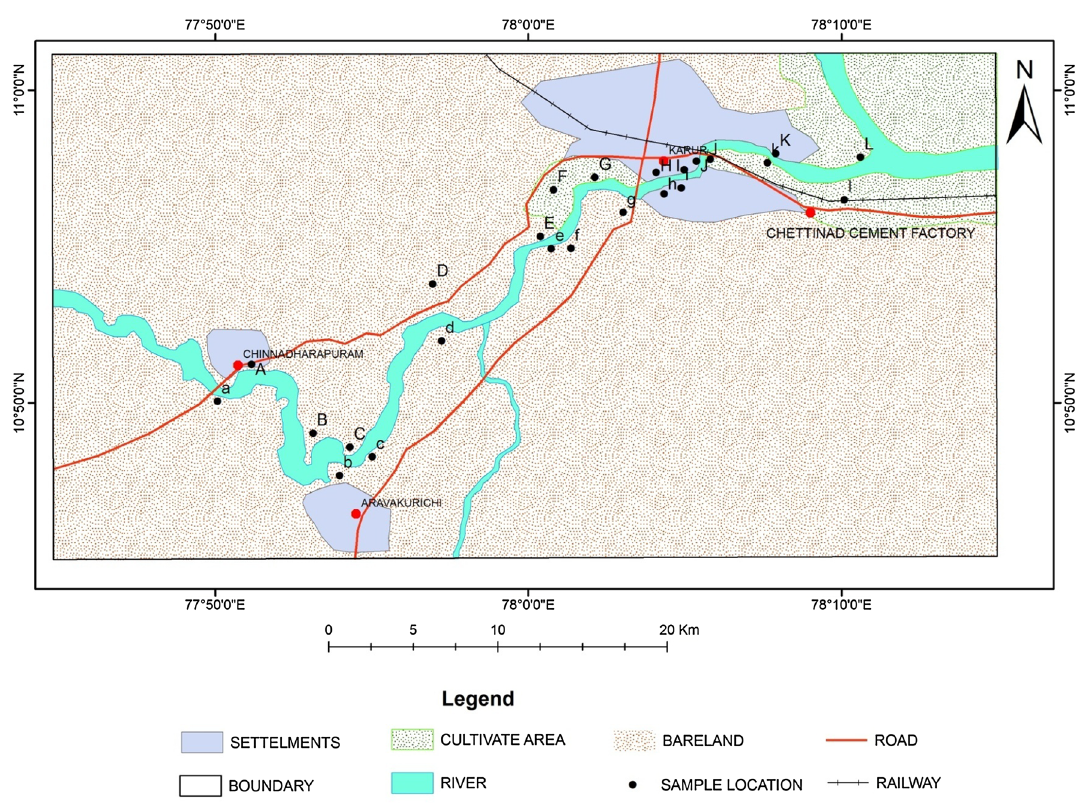
Fig. 1 Location map of the Amaravathi River basin showing sampling